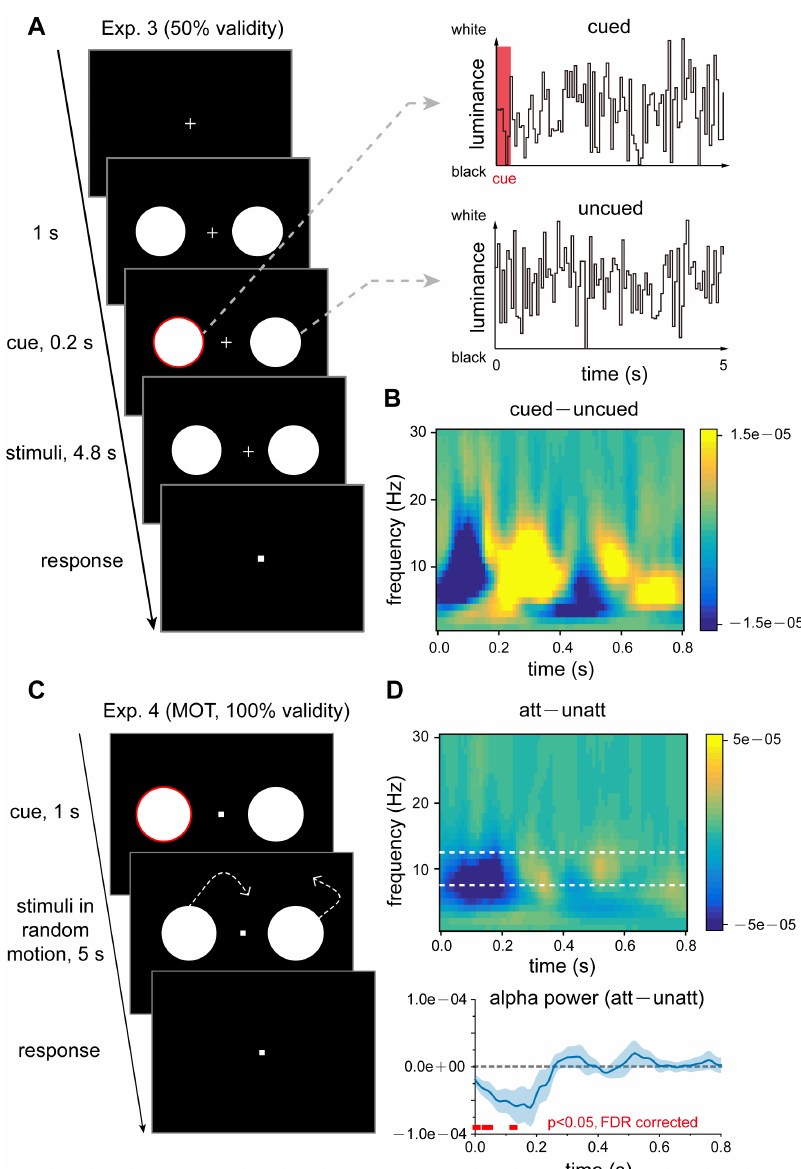
Fig 4. Experiment 3 (50% cue validity) and Experiment 4 (100%cue validity, multiple object tracking [MOT]). (A) In Experiment3 (50%cue validity),subjectsfixated on a centralpointandcovertly attended to 2 discs presentedin the left andright visualfieldsfor target detection. Subjectswere instructed to simultaneously pay attentionto both discs andwereinformedthat the target wouldbe equallylikelyto appearwithinthe discs andthat the initialcue wouldnot predictthe target location.After a noninformative red circlecue (cuevalidity: 50%)appeared around1 of the 2 discs, the luminanceof the 2 discs was independently and randomly modulatedfor 5 s (top: cuedvisualsequence;bottom: uncuedvisualsequence), duringwhichtime subjects wereinstructedto monitora randomly occurringtarget. (B) Grandaverage( N = 16) time–frequency plotsfor cued–uncued TRF powerdifference in Experiment 3 (cuevalidity:50%).Note the prolonged alpha-band switching(blue–redpattern), suggestingthat attentionalshiftingis enhancedwhenattentionis evenlydistributed across the 2 spatiallocations(50%cue validity). (C) In Experiment4 (MOT experiment), a red circle cue at the beginning of eachtrial indicatedwhichdisc the subjectsshouldcovertly attendto for subsequent target detection. The 2 disks werethen movedrandomlyandsmoothlyacrossthe screenfor 5 s, duringwhichtime the subjectswereinstructedto detect the appearance of a target withinthe cueddisc. Here,the cue validitywas 100%,whichmeansthat the targetonly appeared in the cued disk, similarto Experiment 1. (D) Experiment4 results. Top: Grandaverage( N = 11) time–frequency plots for att–unattTRF powerdifference.Bottom: grand average(bluelines, N = 11, mean ± SEM) time coursefor att–unatt TRF powerwithinthe